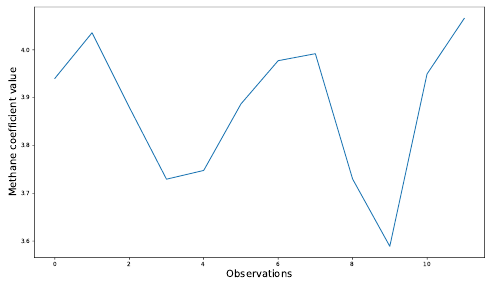
Figure 7. Value of the coefficient x ′ of the same location. The last observation contains a methane